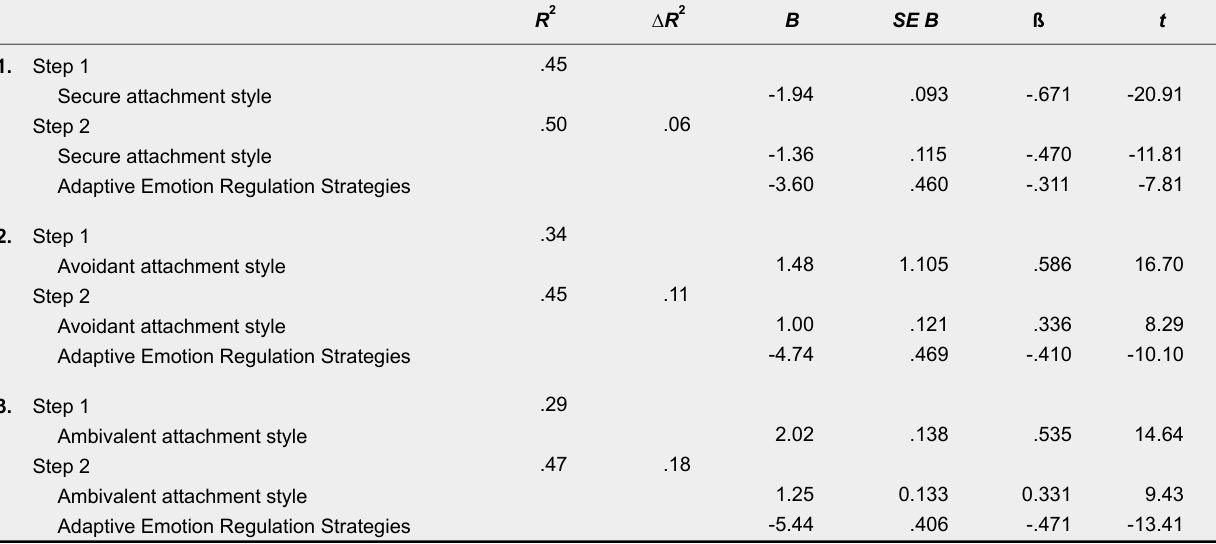
Summary of Regression Analyses for Mediating Role of Adaptive Emotion Regulation Strategies between Attachment Styles and Alexithymia